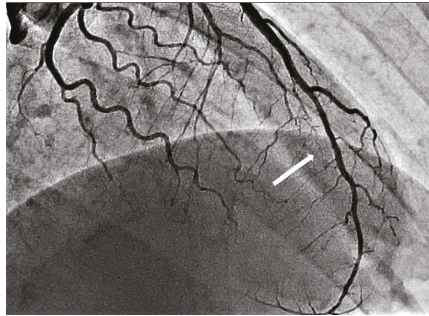
Figure 5: The last coronary angiography shows near-normal left coronary